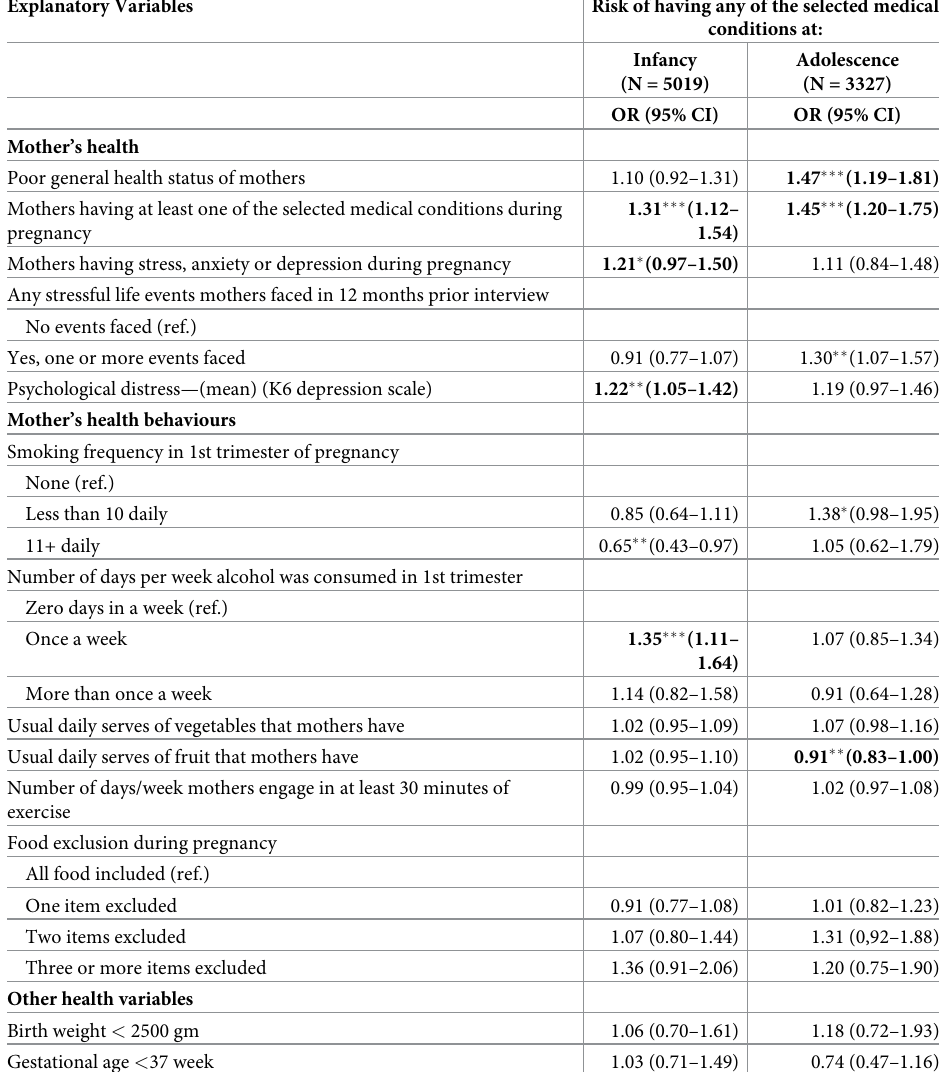
Table 3. Maternal health and health-related behaviours and their associations with children’s having any of the selected medical conditions during infancy (0–1 year of age) and adolescence (12–13 years of age). Explanatory Variables Risk of having any of the selected medical